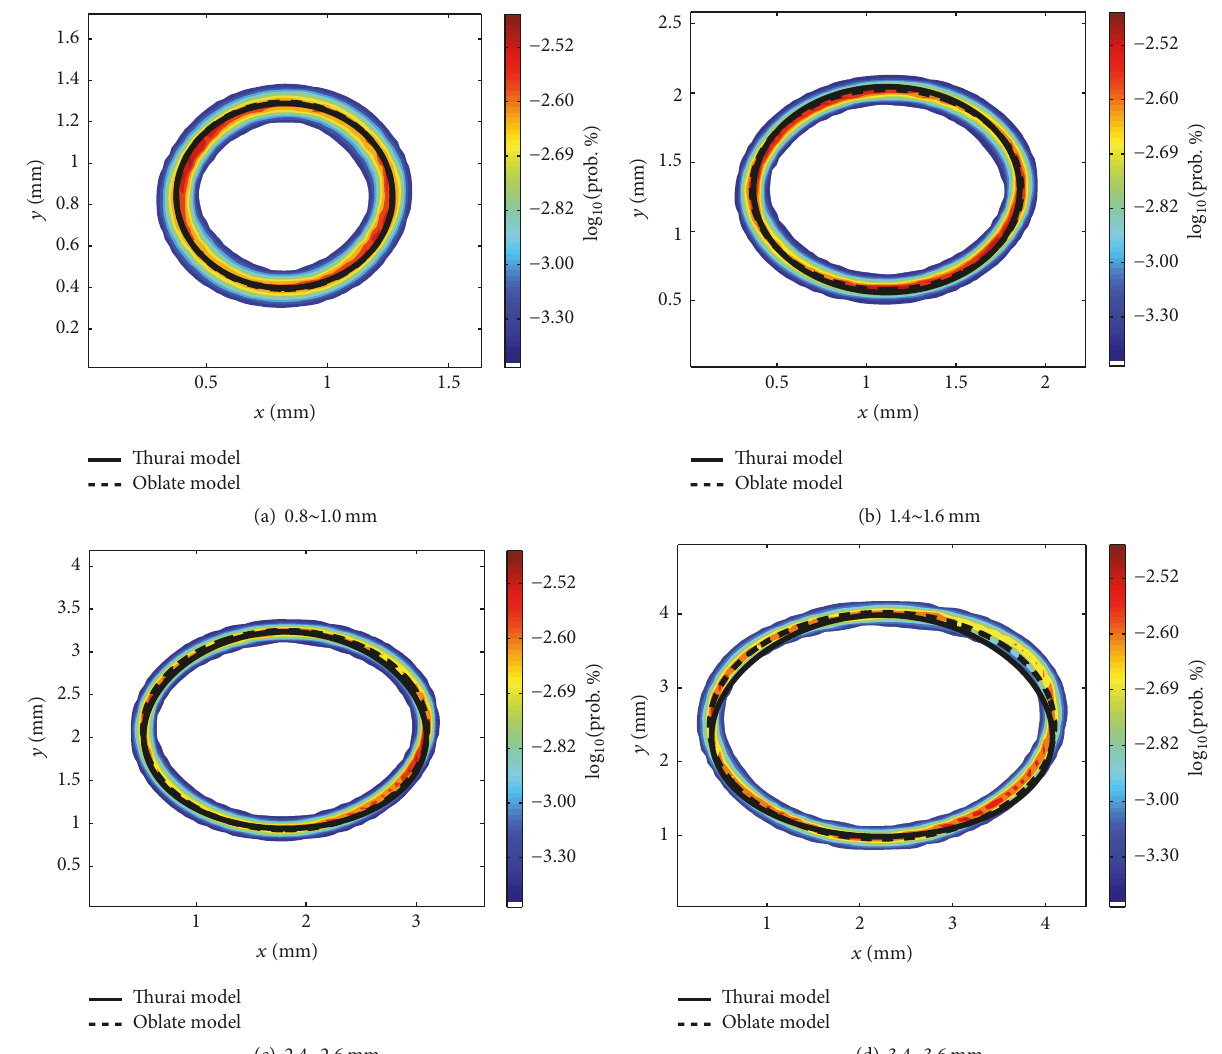
Figure 16: Comparison of the mean shapes of raindrop from present result, TB model (solid line), and oblate model (dashed line).